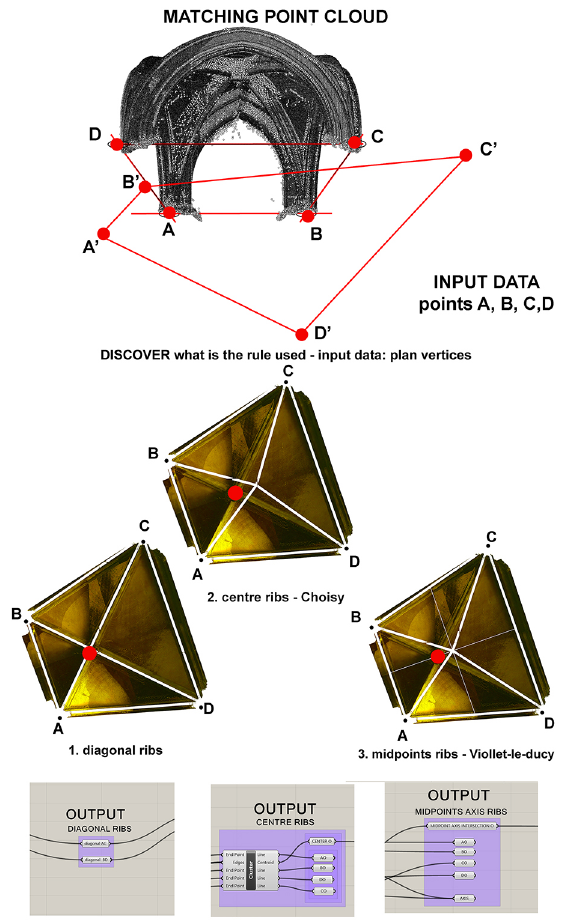
Figure 8 : Matching point cloud trapezoidal quadripartite vault church of S. Lorenzo for plan